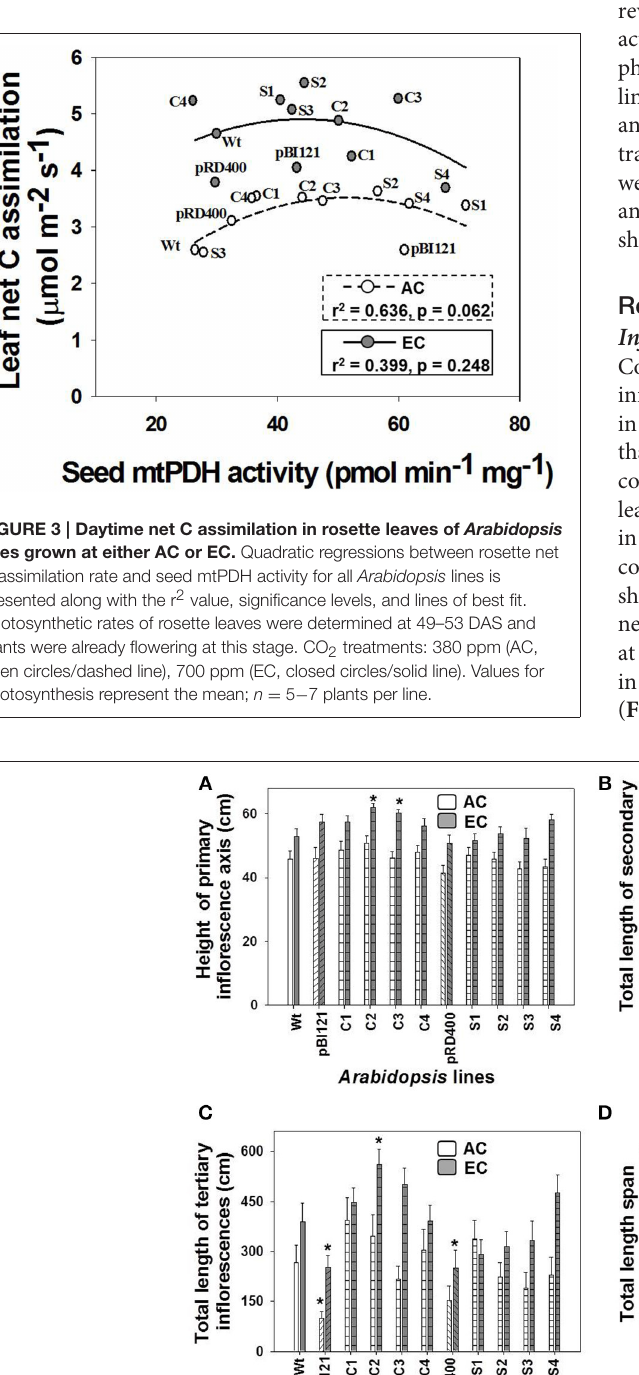
Frontiers in Plant Science |